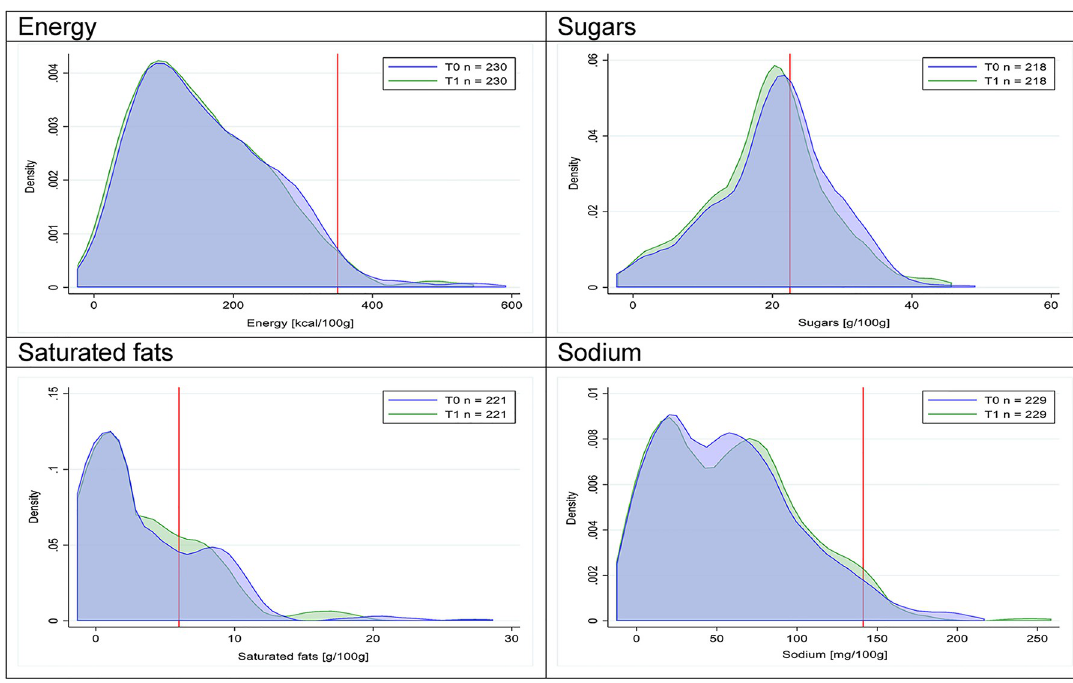
Fig 23. Density curves for the amount of energy and nutrients of concern in desserts and ice creams, longitudinal subsample. The blue line represents the distribution in T0 (preimplementation), the green line represents the distribution in T1 (postimplementation), and the red line represents the cutoff for the amount of energy or nutrients of concern.